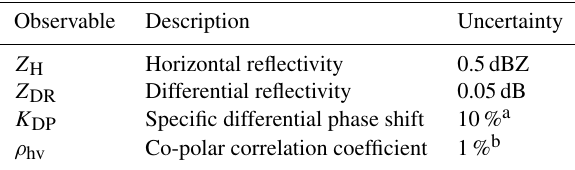
Table 3. Estimated observational errors for X-band observables based on standard and benchmark procedures, adapted from Bringi and Chandrasekar (2001, pp. 359–376) and Wang and Chan- drasekar